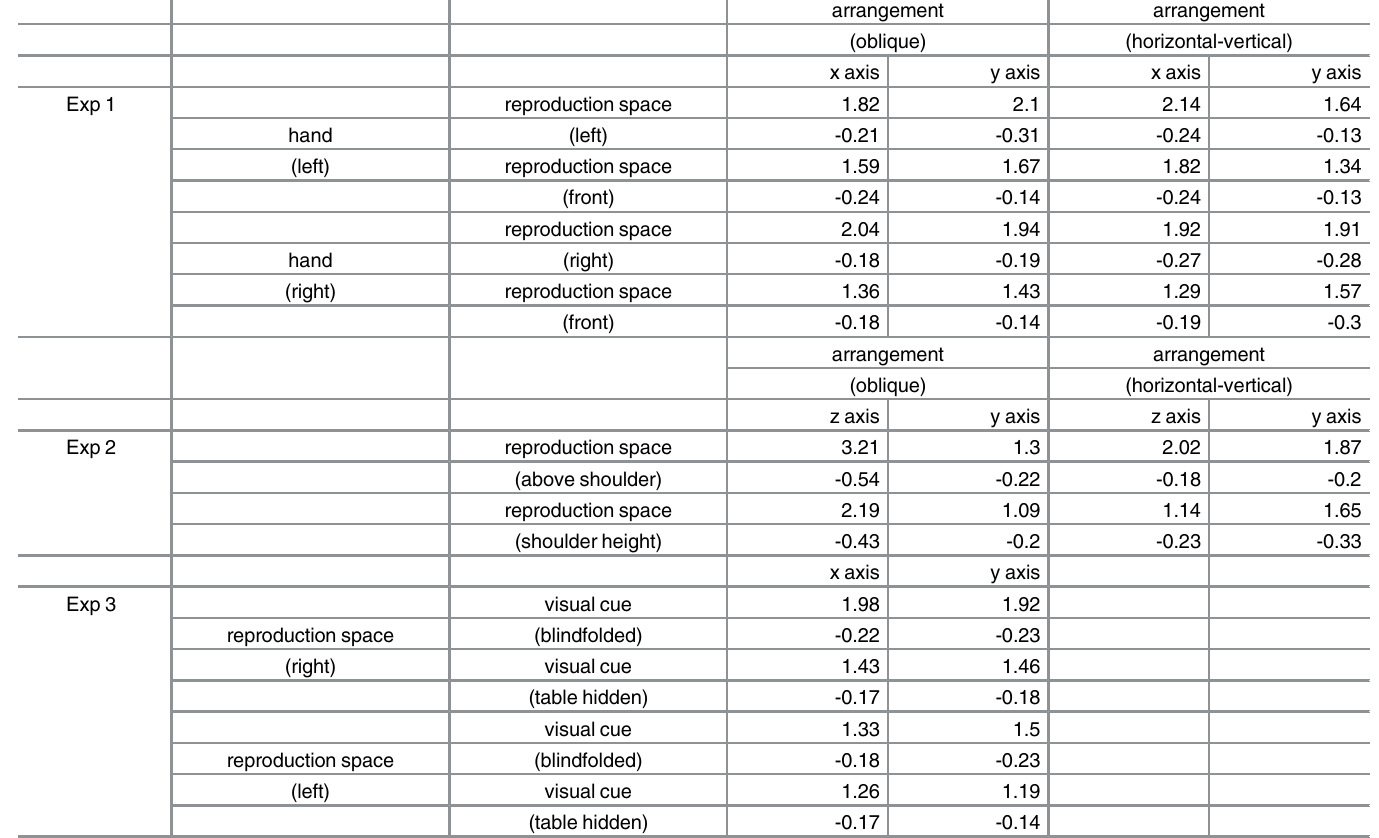
Table 1. Absolute deviations of the reproduced magnet for all three experiments (cm).